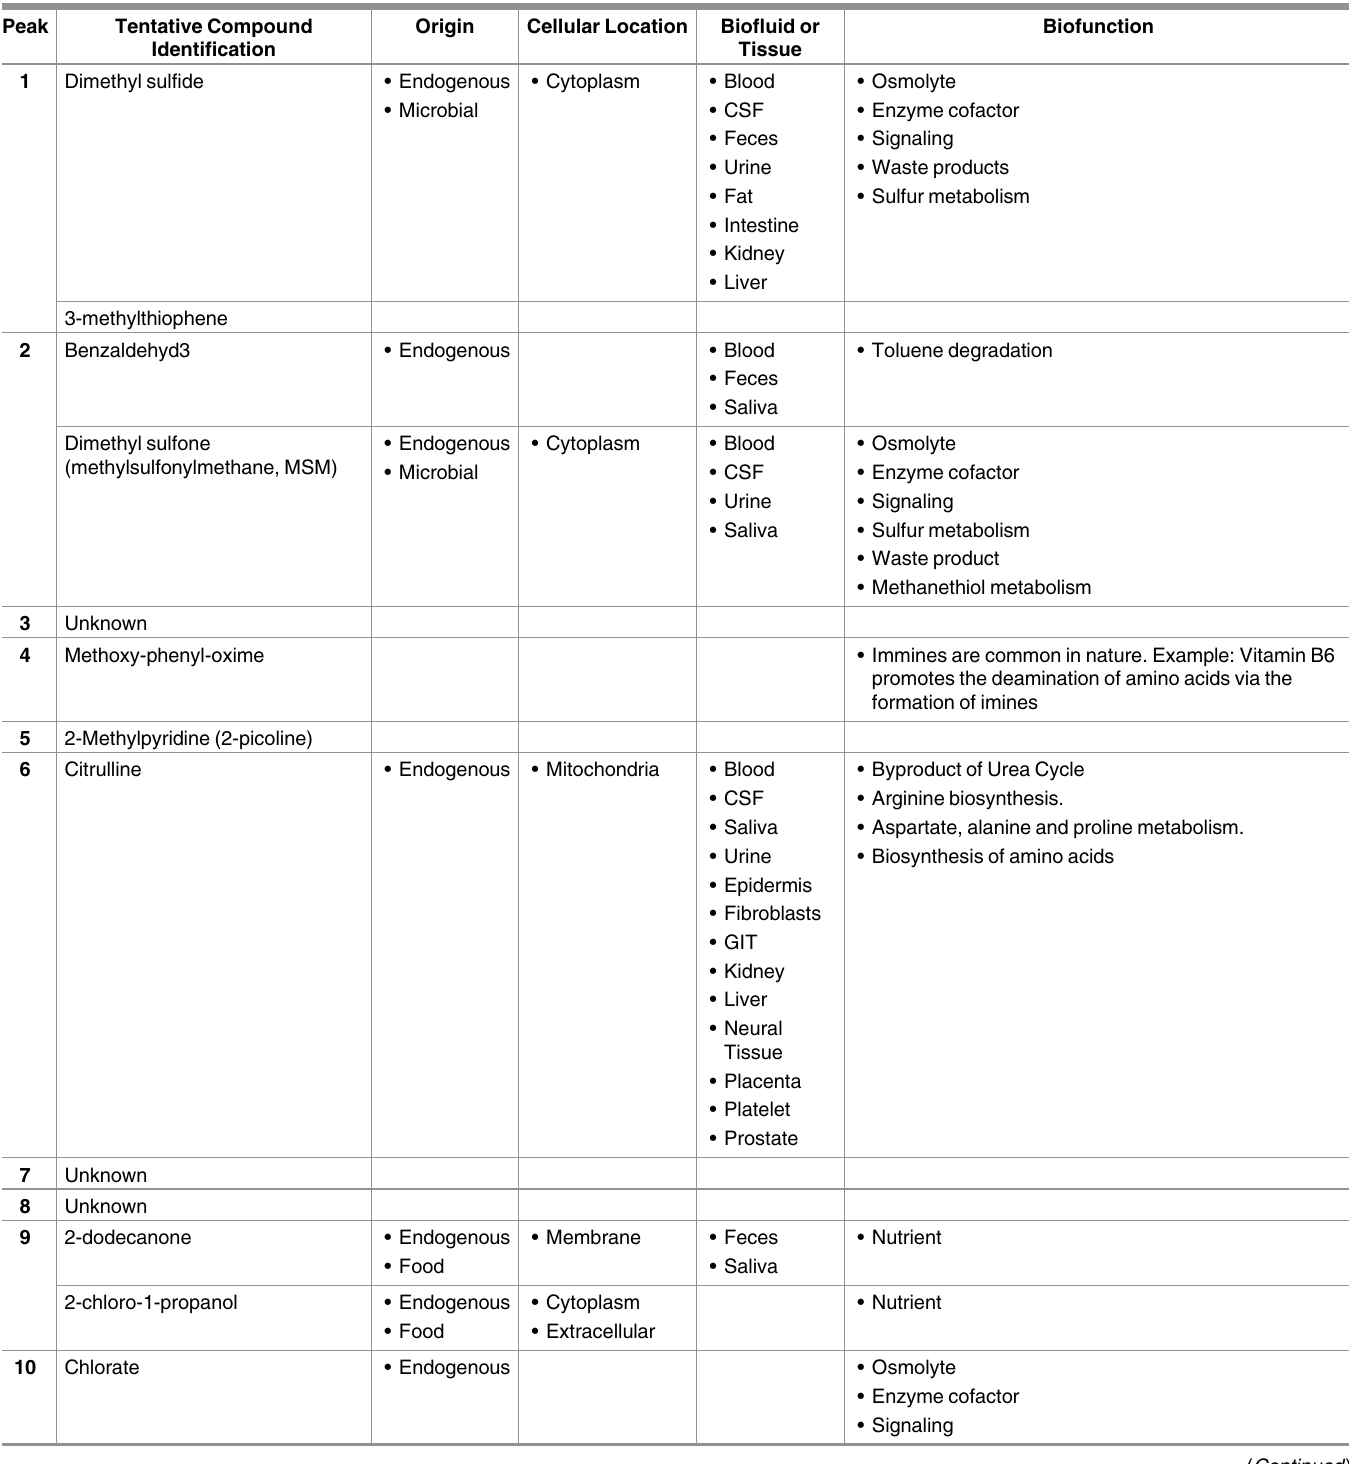
Table 7. Potential sites of origin; cellular and biofluid locations; and biofunctions of tentatively identified volatile organic compounds.